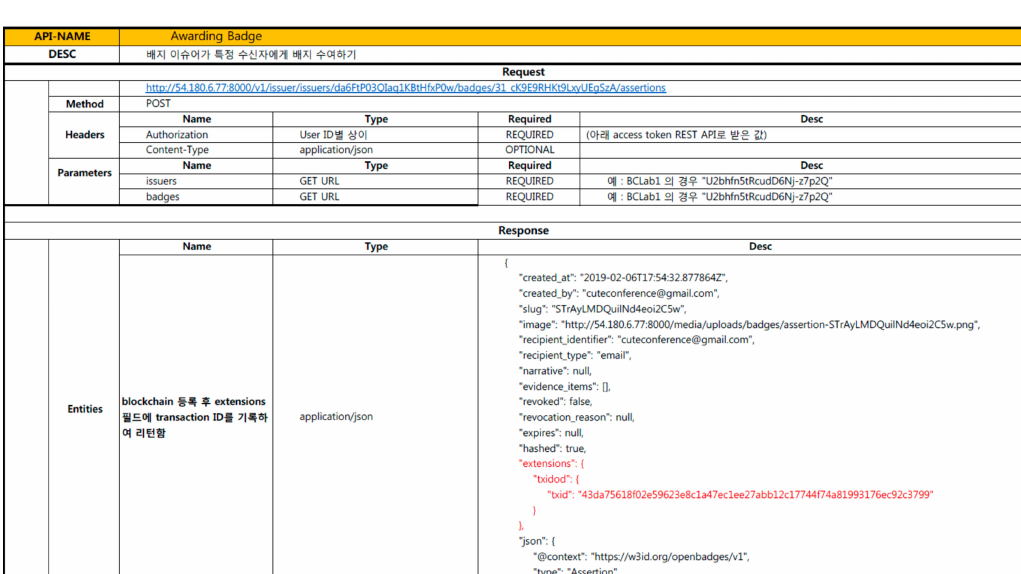
Figure 16. REST API for Issuer Profile.